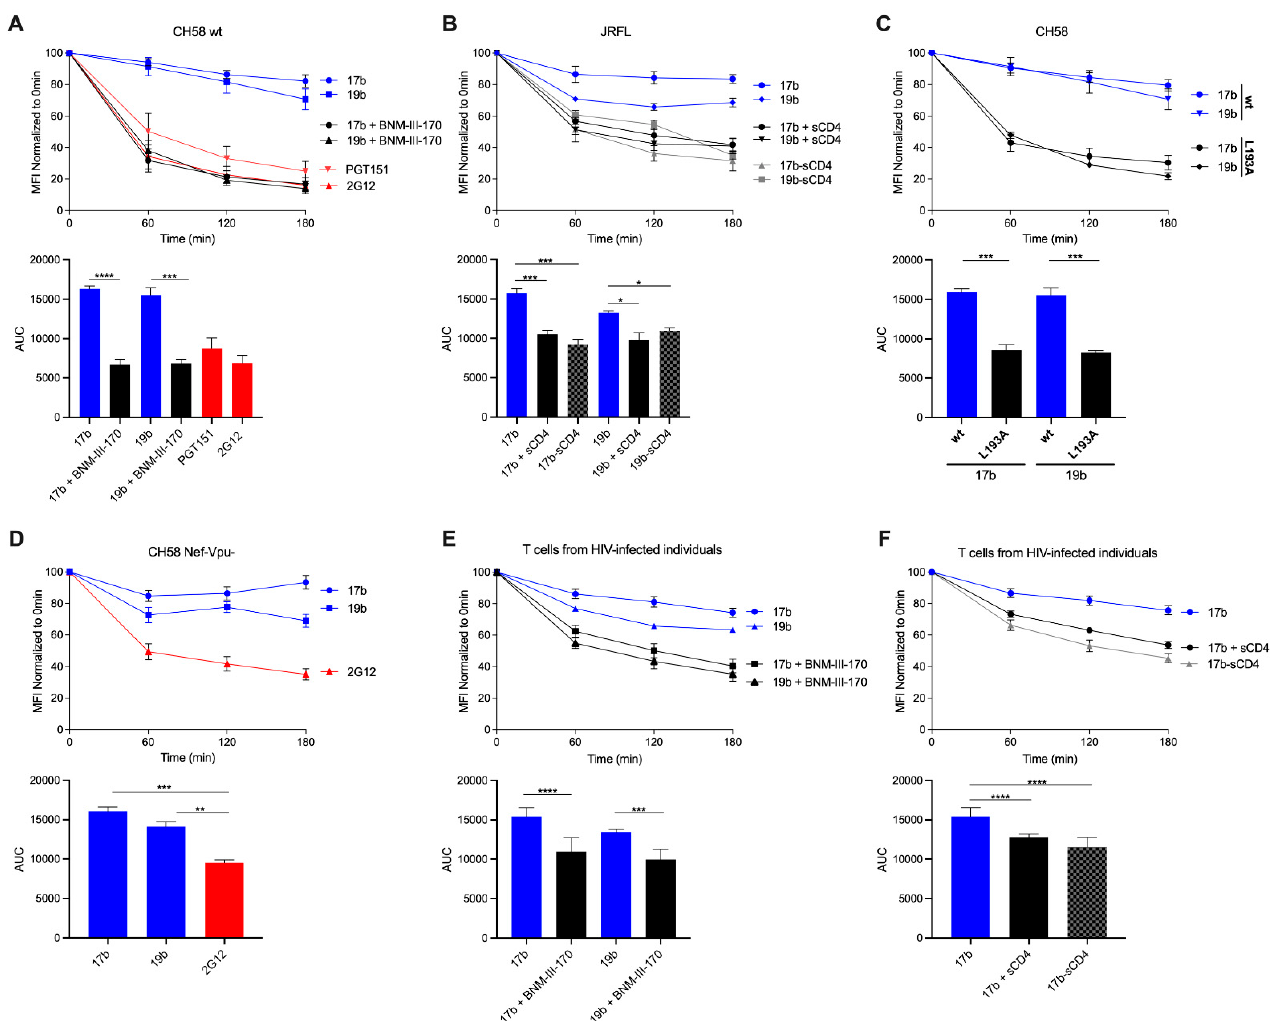
Figure 1. Antibody-internalization of HIV-1 Env from the cell surface can be accelerated upon the selective opening of Env. ( A – D ) Cell surface staining of primary CD4+ T cells infected in vitro with ( A ) CH58 T/F virus, ( B ) JRFL WT virus, ( C ) CH58 T/F WT or L193A virus, and ( D ) CH58 T/F virus defective for Nef and Vpu expression was performed 48 h post-infection. ( E , F ) Primary CD4+ T cells from at least three different HIV-1-infected individuals were isolated and reactivated with PHA-L for 48 h, followed by incubation with IL-2 to expand the endogenous virus. Cell surface staining of endogenously infected primary CD4+ T cells was performed upon reactivation. ( A – F ) Antibody binding was detected using Alexa Fluor 647-conjugated anti-human secondary Abs. (Top) Quantification of remaining antibody–Env complexes on the cell surface over different timepoints is expressed as percentage of the MFI relative to the 0 min timepoint control. (Bottom) Areas under the curve (AUC) were calculated based on MFI data sets using GraphPad Prism software. Error bars indicate means ± the SEM. Statistical significance was tested using an unpaired t test or a Mann-Whitney U test based on statistical normality (*, p < 0.05; **, p < 0.01; ***, p < 0.001; ****, p < 0.0001).